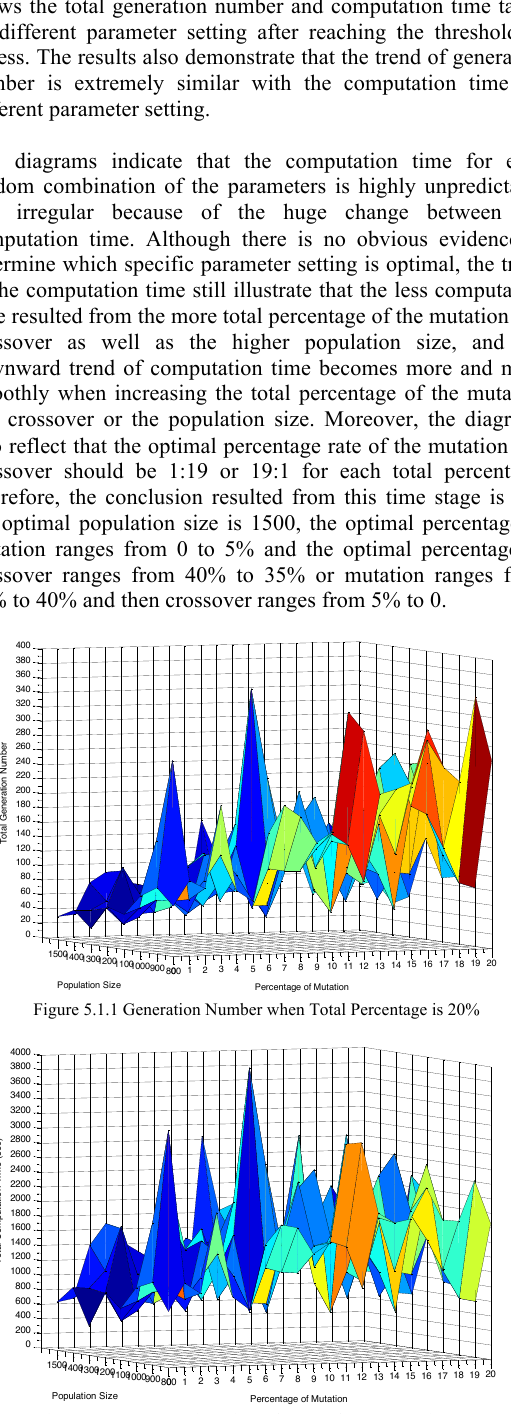
Figure 5.1.2 Computation Time when Total Percentage is